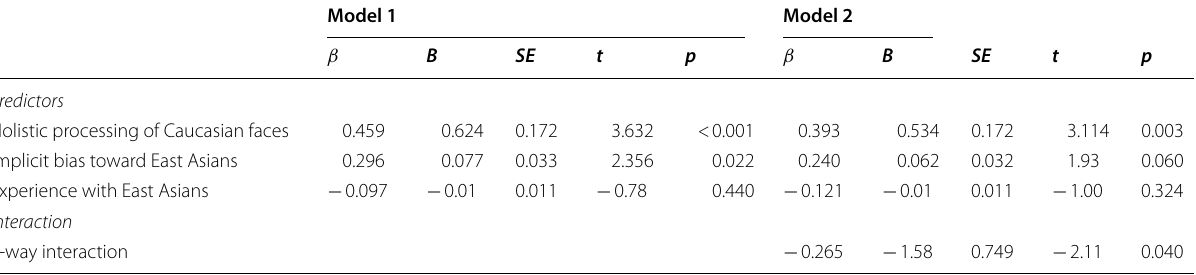
Table 4 Results of the multiple regression analyses on the congruency effect (∆accuracy: accuracy in congruent trials minus accuracy in incongruent trials) in Experiment 1